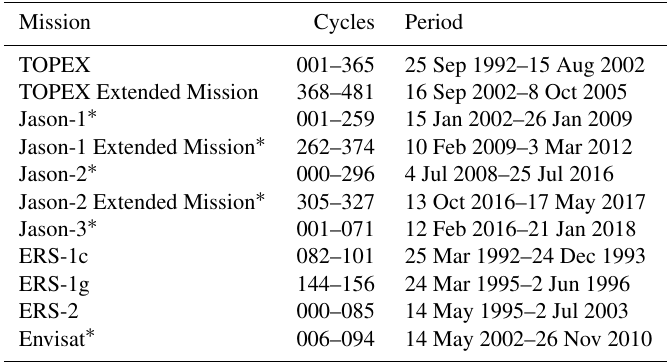
Table 1. The satellite altimeter data used in this study obtained from OpenADB at DGFI-TUM (Schwatke et al., 2014). The corrections listed in Table 2 are applied to all these missions. Most missions are retracked using the ALES retracker (Passaro et al., 2018), marked by ∗ , with TOPEX and ERS using ocean ranges as provided in SGDR datasets.